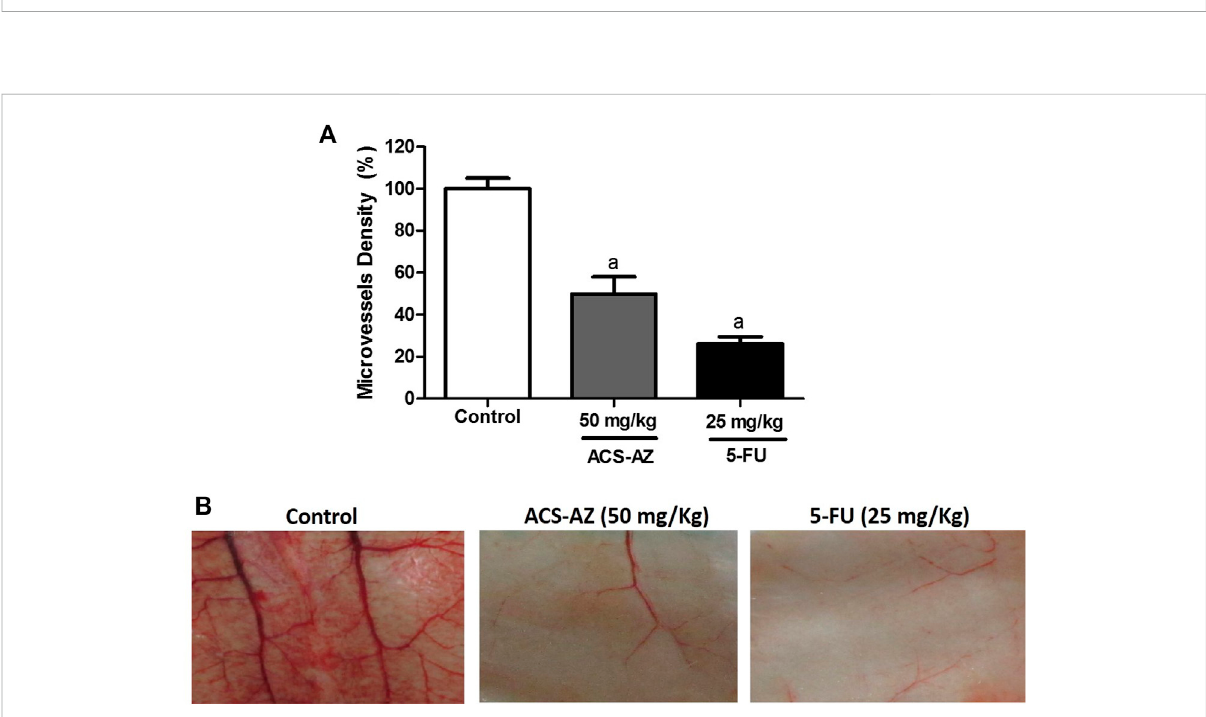
FIGURE 3 Effect of a 7-day treatment with ACS-AZ (50 mg/kg) or 5-FU (25 mg/kg) by intraperitoneal route on microvessel density (%) in Ehrlich ascites carcinoma-bearing mice. Animals ’ peritoneum were cut and photographed. (A) Microvessel density (%) represents the blood vessel area per fi eld in selected vascularized areas divided by the whole area. (B) Representative images of cut from animal ’ s peritoneum into a standard size (1 cm × 1 cm). Theresultsrepresentthemean±SEM( n =8)analyzedbyone-wayANOVAfollowedbyTukeytest: a p < 0.05vs.control.ACS-AZ:N ’